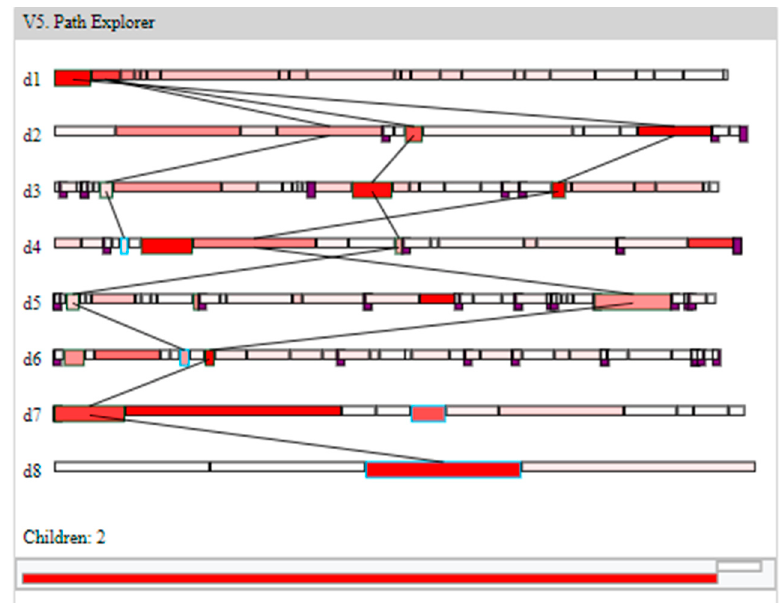
Figure 18. The Path Explorer Panel depicting all the levels within the selected path of the ontology, where each level maintains a set of rectangles representing all sibling entities and a text label reflecting its depth within the levels of the ontology.